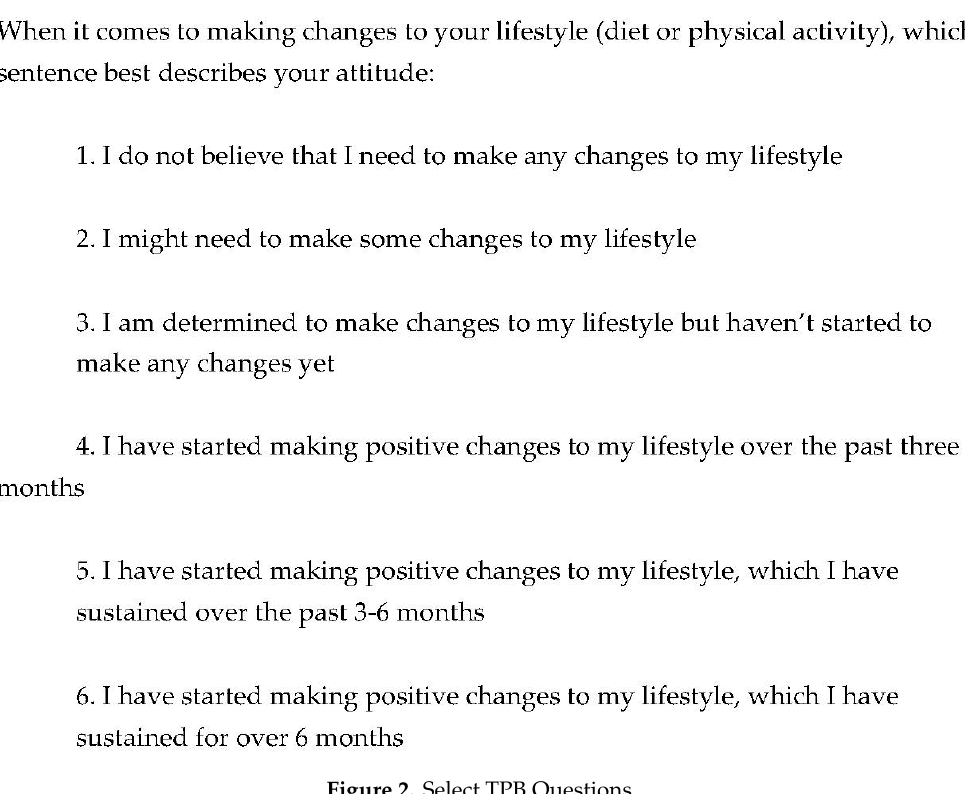
Figure 2. Select TPB Questions.